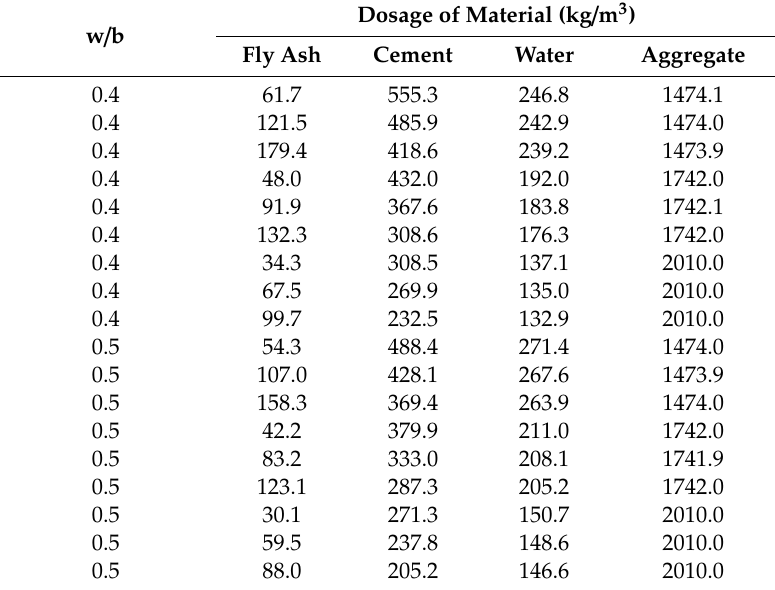
Table 2. Mix proportions of fly ash